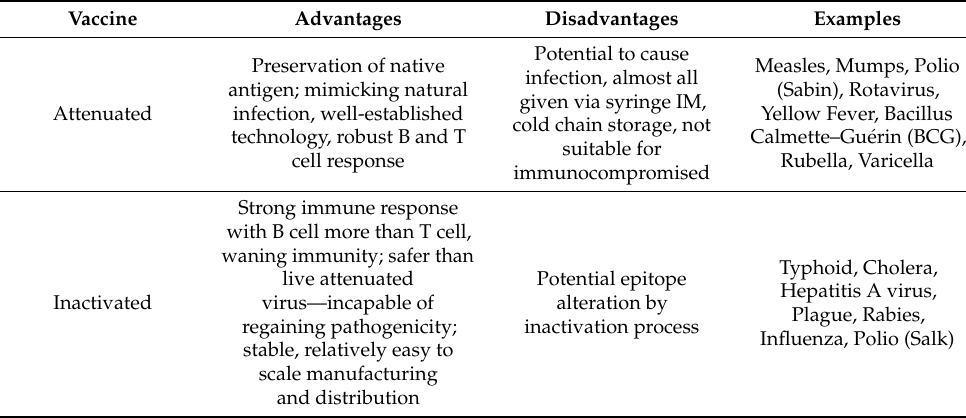
Table 1. The advantages and disadvantages of different